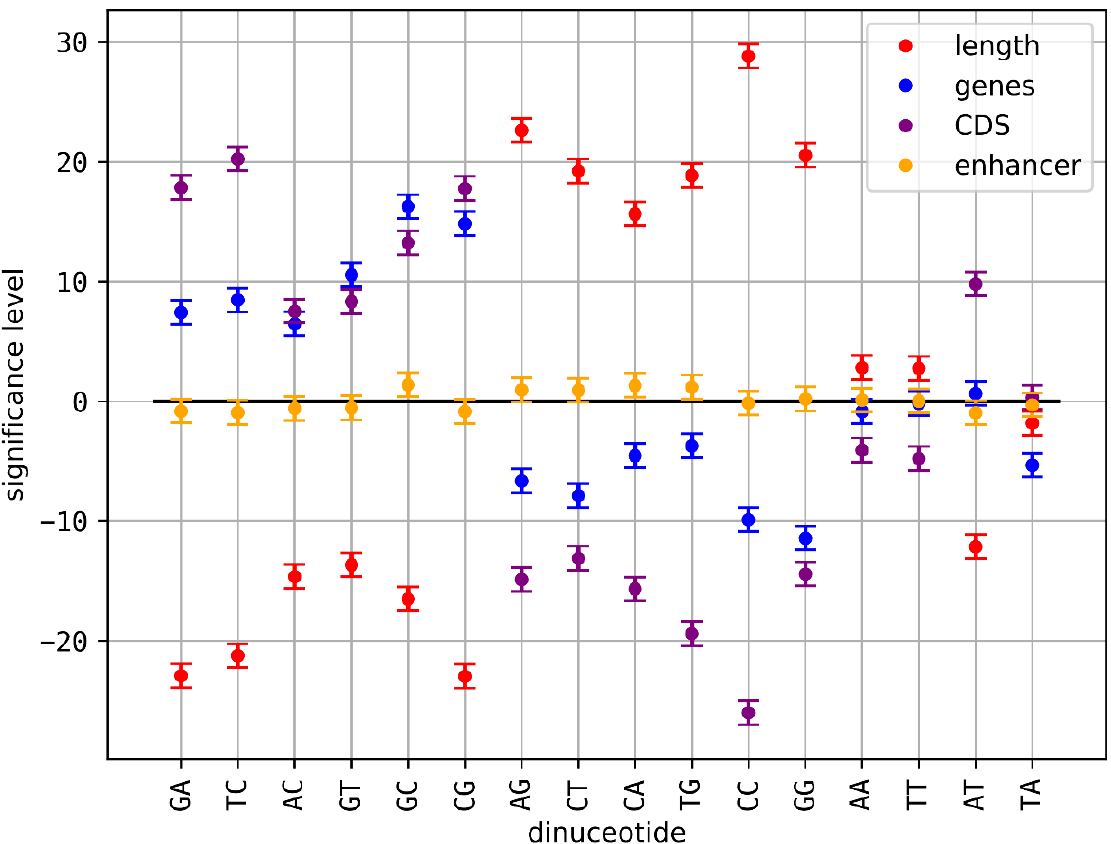
Figure 3. Significance levels of dinucleotide-attribute correlations: normalized dinucleotide contents were correlated with different attributes (gene content, CDS content, normalized enhancer count and chromosomal length (in bp)). Significance levels were calculated in relation to (random) Chargaff models samples (see Section 2.1). Values deviating more than ± 1.0 from zero are not expected by the model and are thus considered significant. Table 1. Dinucleotides correlated or anti-correlated with attributes: lists of dinucleotides signifi- cantly correlated or anti-correlated with chromosome length, gene content, CDS content or enhancer count (see Section 2.3, Figure 3, Table S3). Re-occurring sets of dinucleotides are highlighted with different background colors.